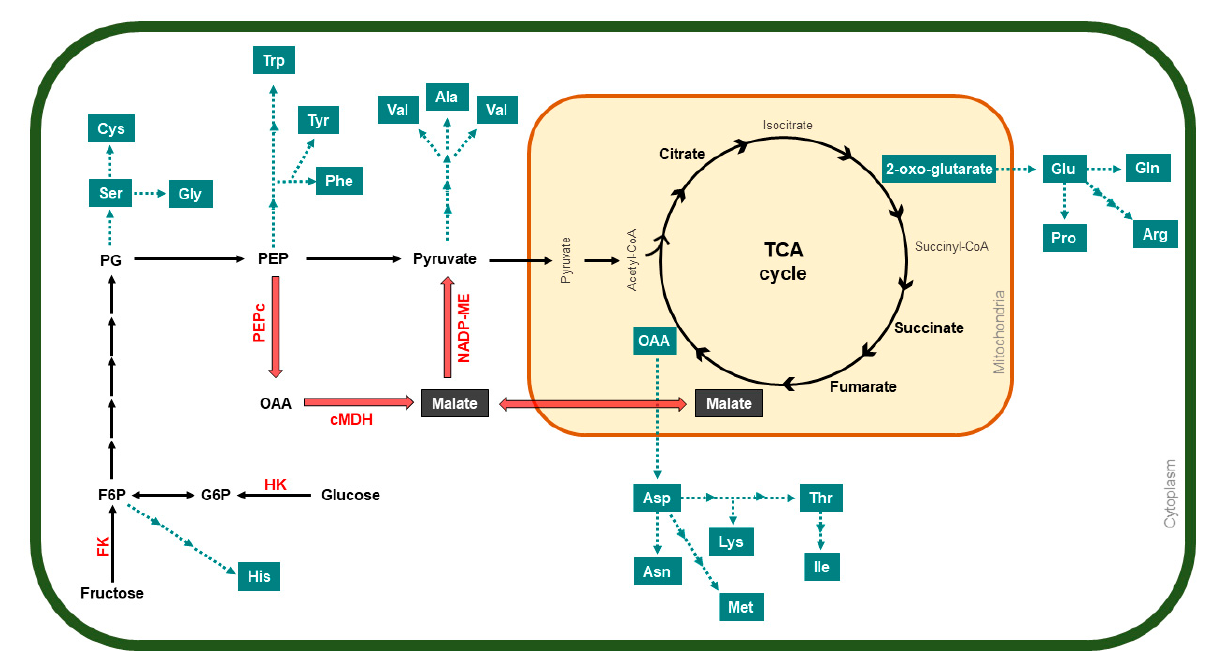
Figure 3. A general description of organic acid and amino-acid metabolism pathway during apple development, which involves glycolysis and the TCA cycle. Red arrows indicate the expected route of malate formation, accumulation, and degradation in apples. Blue boxes and arrows mark the diverse biosynthesis pathways of the different amino acids. In red letters, the enzymes are abbreviated as follows: PEPc, phosphoenolpyruvate carboxylase; cMDH, NAD-dependent malate dehydrogenase; NADP-ME, NADP-dependent malic enzymes; FK, fructokinase; HK, hexokinase.